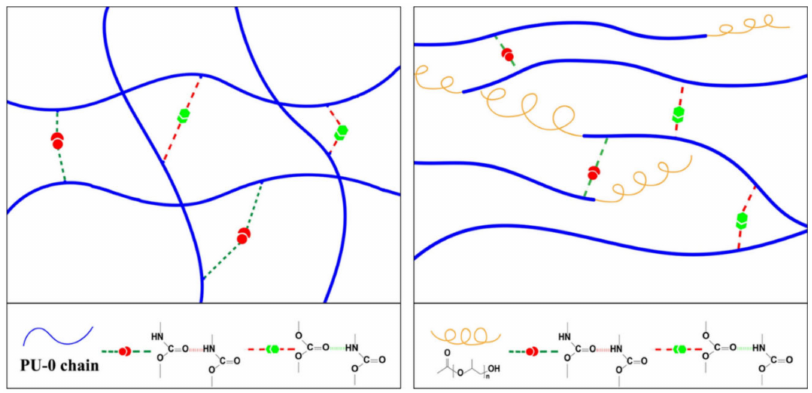
Figure 18. Schematic model of H-bonds in PU ( left ) and PU-containing PPG segments ( right ). Reproduced from [148] with permission from Springer